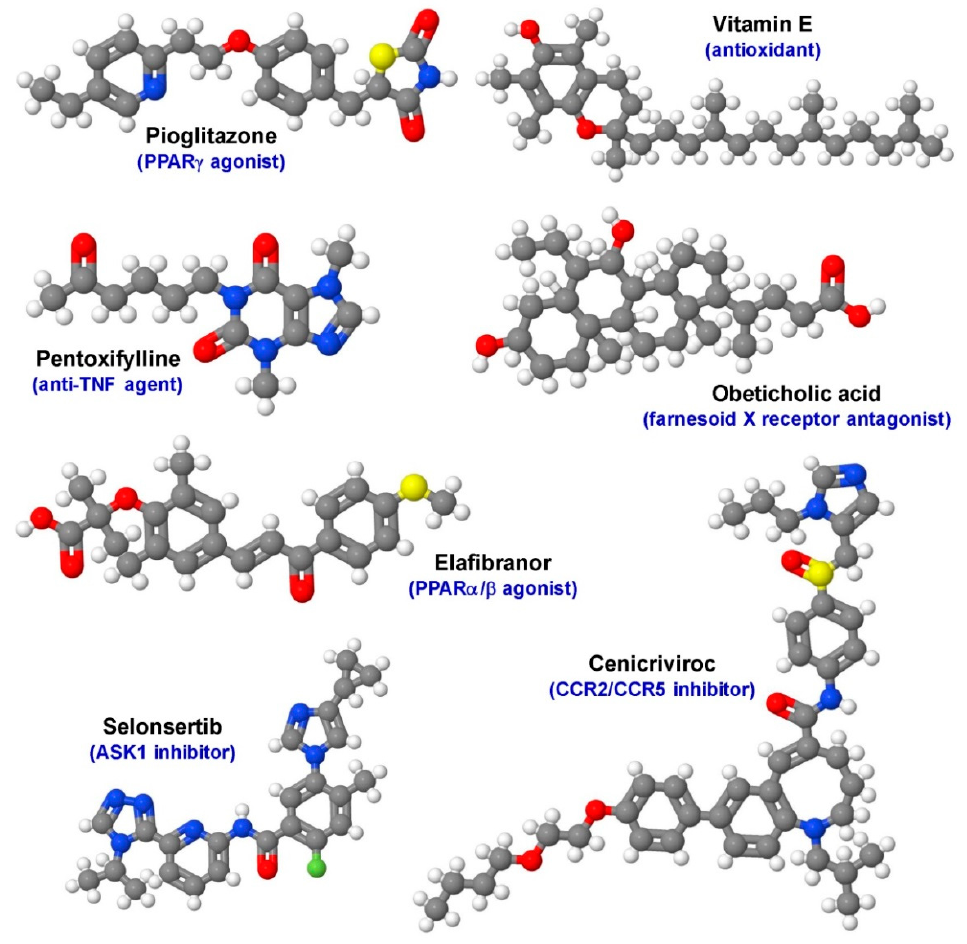
Figure 2. Established compounds and drug candidates evaluated for the treatment of NAFLD / NASH in clinical trial phase III . Pioglitazone (PPAR γ agonist), vitamin E (antioxidant), pentoxifylline (anti-tumor-necrosis factor- α (TNF- α ) agent), Obeticholic acid (farnesoid X receptor antagonist), cenicriviroc (CCR2 / CCR5 inhibitor), elafibranor (PPAR α / δ agonist), and selonsertib (ASK1 inhibitor) have di ff erent molecular targets. The di ff erent biological activities of the drugs point to the complexity of NAFLD / NASH, having a large variety of potential therapeutic drug targets. The depicted structures were generated with the open source molecule viewer Jmol using data deposited in the PubChem compound database with CIDs: 4829, 14985, 4740, 447715, 11285792, 9864881, and 71245288). For more details about the biological activity of each drug refer to [32].